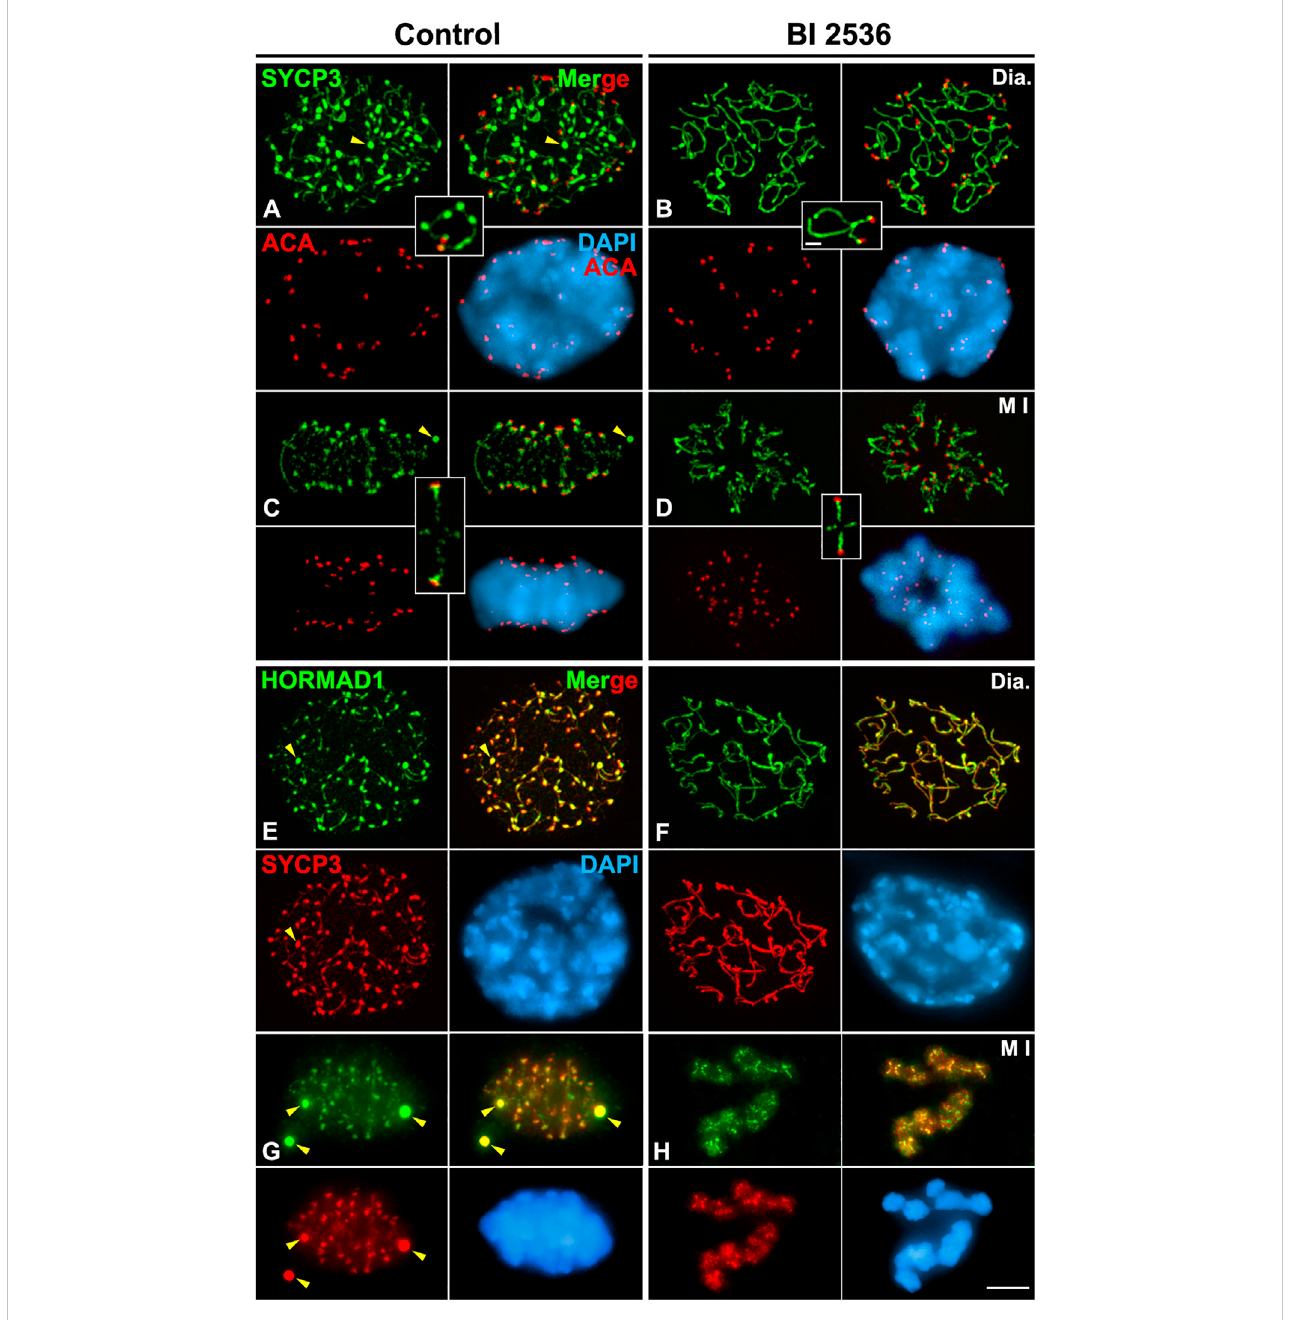
PLK1 regulates the release of SYCP3 and HORMAD1 from desynapsed LEs in diakinesis and its accumulation at the inner centromeres in metaphase I spermatocytes. Double immunolabelings of SYCP3 (green) and kinetochores (ACA, red) (A – D) , and SYCP3 (red) and HORMAD1 (green) (E – H) , and counterstainingofthechromatinwithDAPI(blue)onsquashedcontrol (A,C,E,G) andBI2536-treated (B,D,F,H) spermatocytes.Representativespermatocytes and selected autosomal bivalents at (A,B,E,F) diakinesis (Dia.), and (C,D,G,H) metaphase I (M I) are shown. Yellow arrowheads indicate SYCP3 agglomerates in the nucleoplasm of diakinesis spermatocytes (A,E) , and in the cytoplasm of metaphase I (C,G) spermatocytes. Scale bars represent 5 μ m in (A – H) , and 1 μ m in selected diakinesis and metaphase I bivalents in (A – D) .